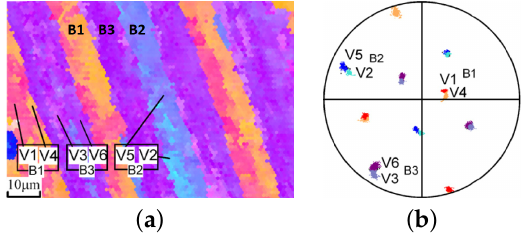
Figure 2. ( a ) Inverse Pole Figure (IPF) map of a 18Ni-8Co-5Mo maraging steel and ( b ) 100 pole figure, showing the crystal-orientation. Blocks are made of 2 subblocks with a low-angle misorientation of about 10 degrees (V1–V4, V2–V5 and V3–V6). Color legend is given in Figure 1a. Adapted